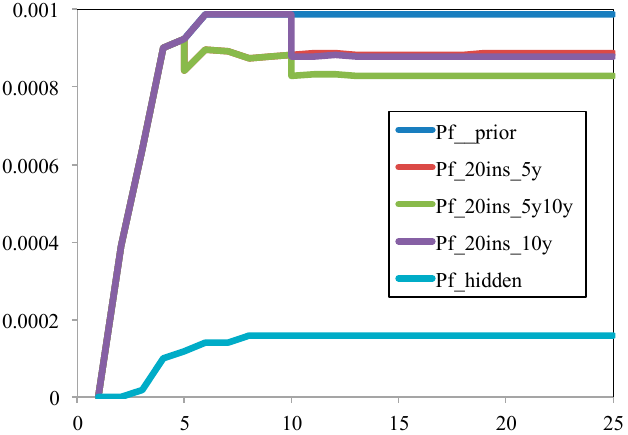
Figure 10. Updated probability of failure with 20 inspections and different inspection dates.